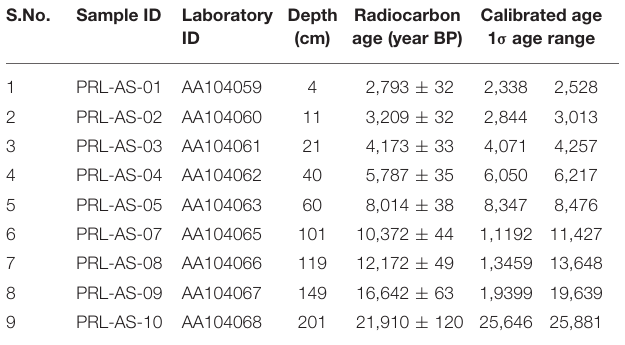
TABLE 1 | Calibrated radiocarbon ages for the sediment core SK-304A/05. S.No.